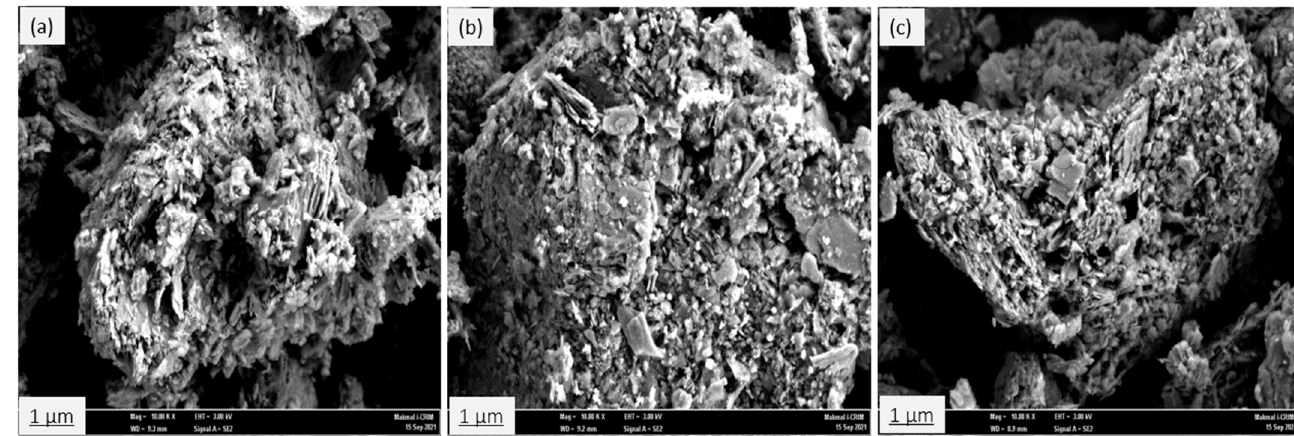
Figure 8. FESEM micrographs of ( a ) NZ, ( b ), PZ, and ( c ) SZ, at a magnification of 10,000×.